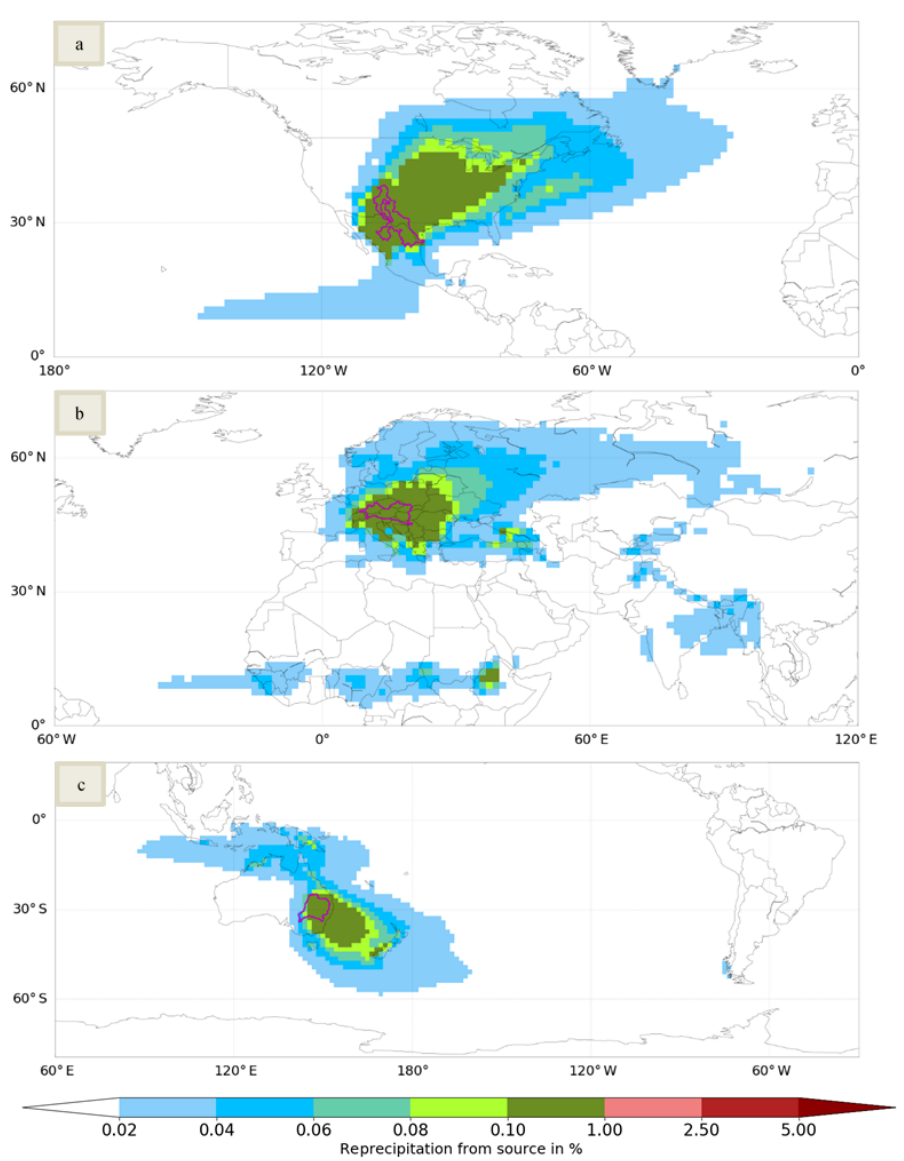
Figure 3. Examples for yearly evaporationsheds of basins. (a) Basin ID 1463188 (part of the Rio Grande basin; E input : 502.4mma − 1 ; unas- signed: 1.3%): the colored area covers 70.1% of the assigned water. (b) Basin ID 1019324 (part of the Danube basin; E input : 609.4mma − 1 ; unassigned: 4.0%): the colored area covers 60.6% of the assigned water. (c) Basin ID 2245569 (part of the Murray–Darling basin; E input : 503.5mma − 1 ; unassigned: 0.5%): the colored area covers 59.4% of the assigned